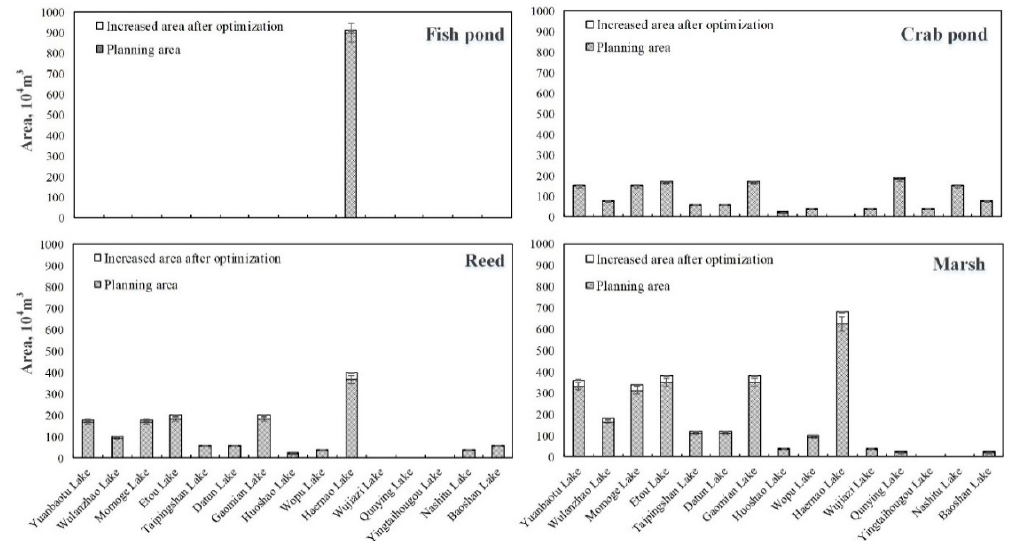
Figure 6. The area of each ecological functional area of the lakes at medium flow level (the shaded part is the planned value; the blank part is the added value after optimization).